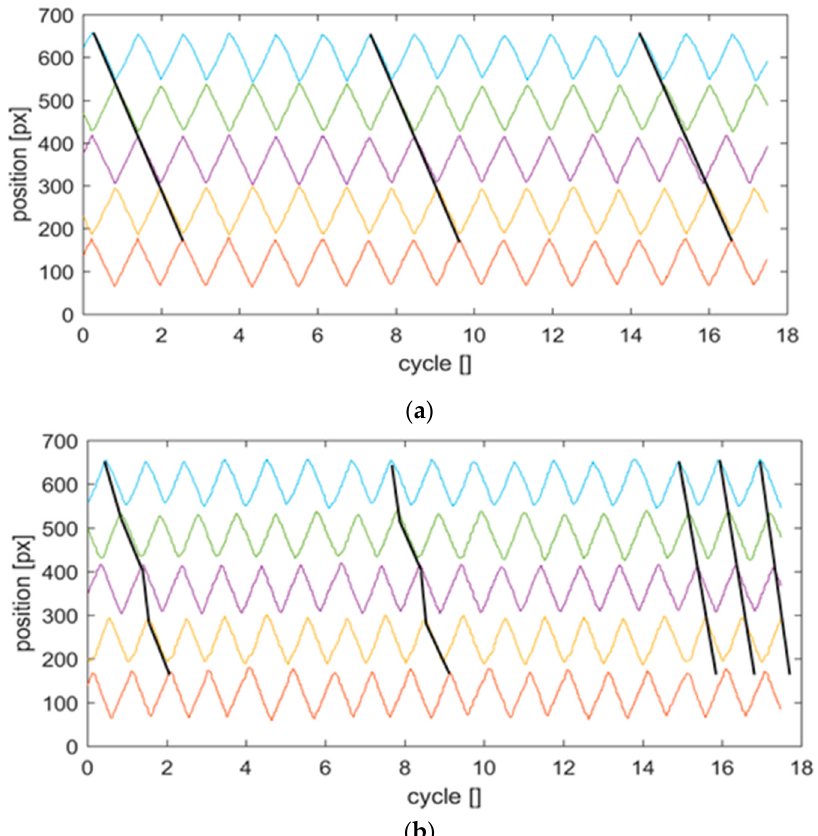
Figure 5. Position trajectories of the five flap tips during the feedback control loop; ( a ): flaps in reference case (air); ( b ): flaps in highly viscous liquid. The black lines indicate the phase relationships between maxima of neighboring flaps over time. The position corresponds to the centroid coordinate of the flap tip marker in pixel units along the horizontal image axis in Figure 3. The colors indicate the different flaps (red: flap i = 1, blue: flap i = 5). Note that we selected for visibility reasons in the plot for air the initial phase shift between pairs of cilia to be at the extreme value of 180°, which results in out-of-phase beating, which is completely outside the range for a metachronal synchronization. Therefore, the black lines in the upper plot do not indicate any synchronization, as there is no interaction between the flaps.